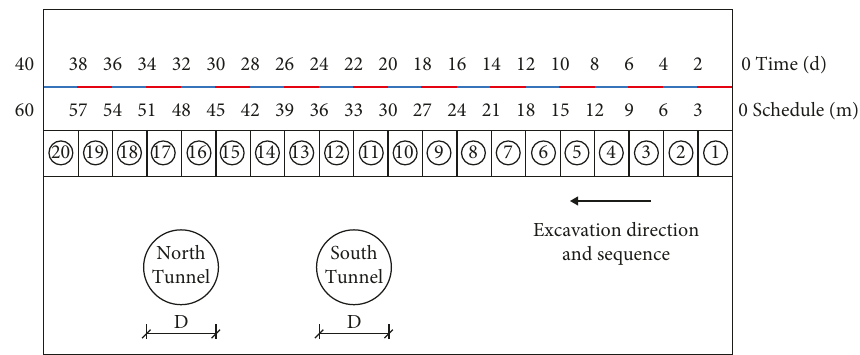
Figure 5: Excavation sequence of new pedestrian